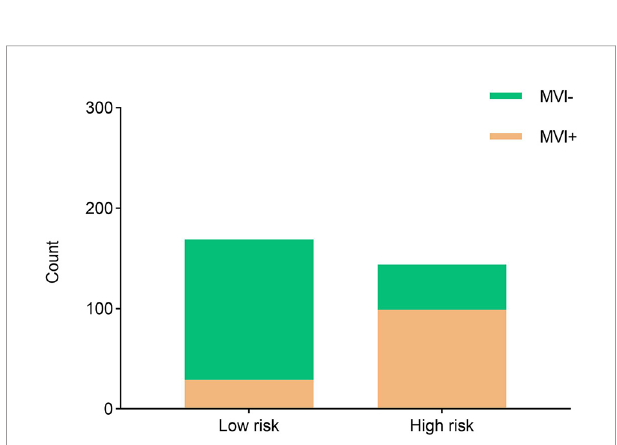
FIGURE 5 | The risk-classi fi cation performance of the radiomics nomogram in all 313 patients. MVI+, patients with microvascular invasion; MVI − , patients without microvascular invasion.